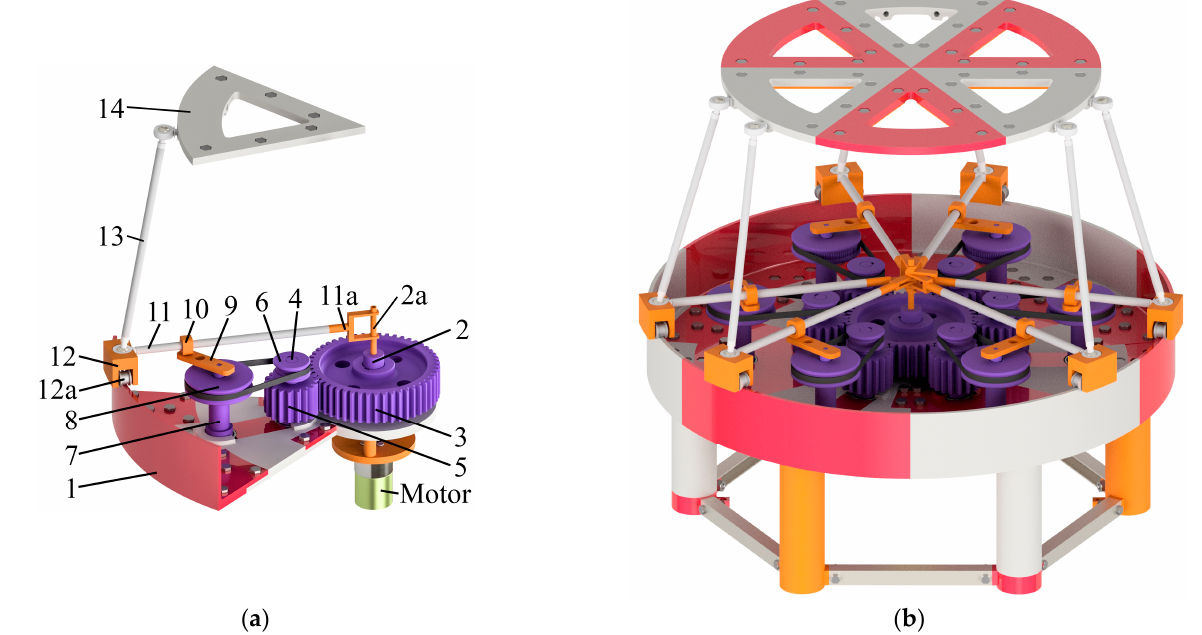
Figure 4. Assembling virtual prototype (CAD model) of the hexapod: ( a ) single kinematic chain with a driving part; ( b ) complete mechanism model. Table 2. Geometrical dimensions of the hexapod links.